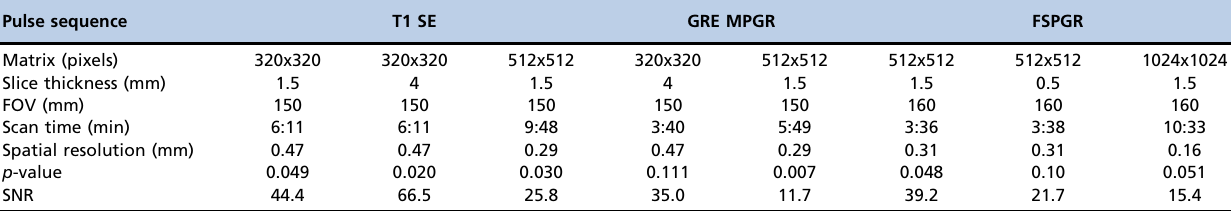
Table 3 - Summary of factors influencing the appropriateness of different MRI sequences for measuring maturing cartilage using phantom 1. Pulse sequence T1 SE GRE MPGR FSPGR Matrix (pixels)